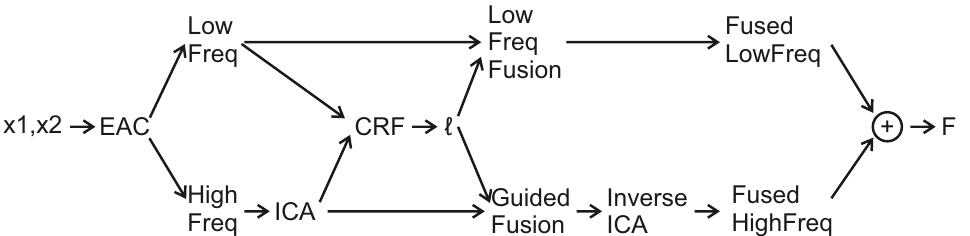
Figure 1. CRF-Guided fusion Framework for input images x 1 , x 2 , labels (cid:96) as estimated from the CRF minimization, and the fused image F is constructed by the addition of the low-frequency and high-frequency fusion results.